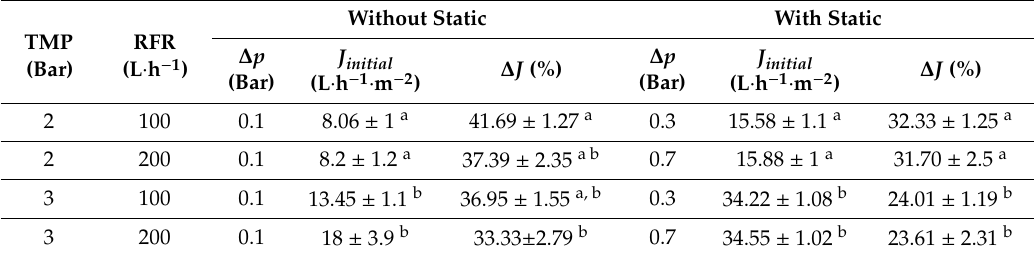
Table 1. Di ff erence of pressure, initial permeate flux and percentage change of permeate flux for di ff erent trans-membrane pressures (TMPs) and retention flow rates (RFRs) in absence and presence of static turbulence promoter. Results are represented by mean value with standard deviation ( ± values). In superscript, dissimilar alphabet represents the significant di ff erence between results, evaluated by the Tukey’s post hoc